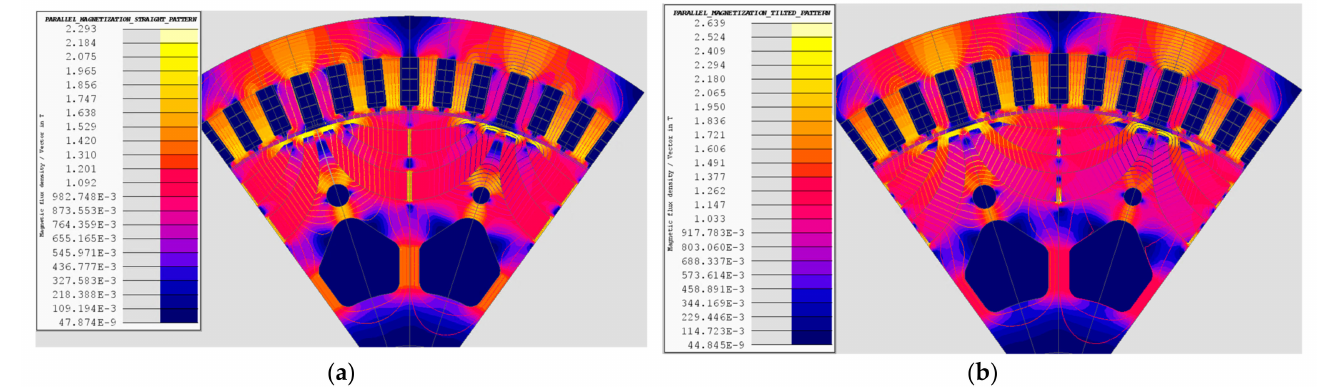
Figure 10. Baseline motor, no-load flux density distribution: ( a ) parallel magnetization: straight pattern; ( b ) parallel magnetization: tilted